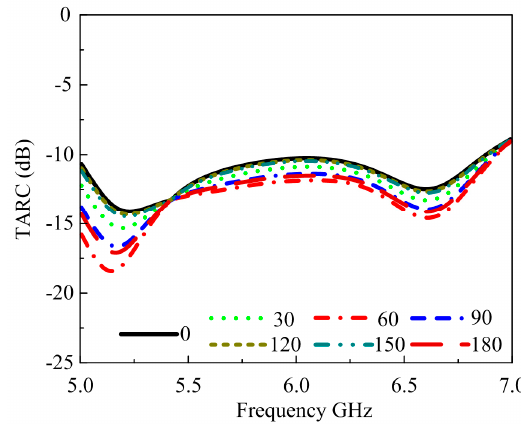
Figure 15. Proposed simulated TARC.